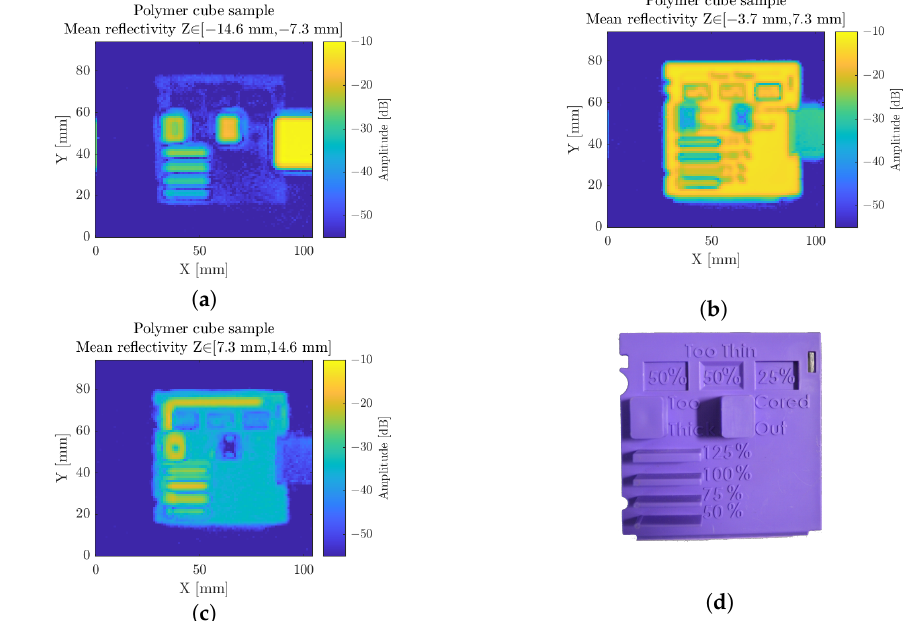
Figure 12. The polymer cube scan, featuring several geometrical test structures, depicted in different longitudinal ranges of interest. Namely, ( a ) is centered on the foreground protrusions, ( b ) is on the main sample plane, ( c ) is over the background features. ( d ) Photography of the